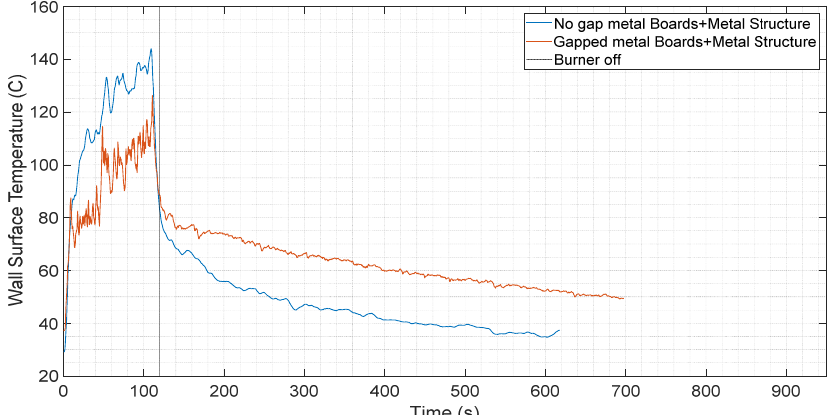
Figure 21. No-gap metal boards on SYP deck assembly after the test.